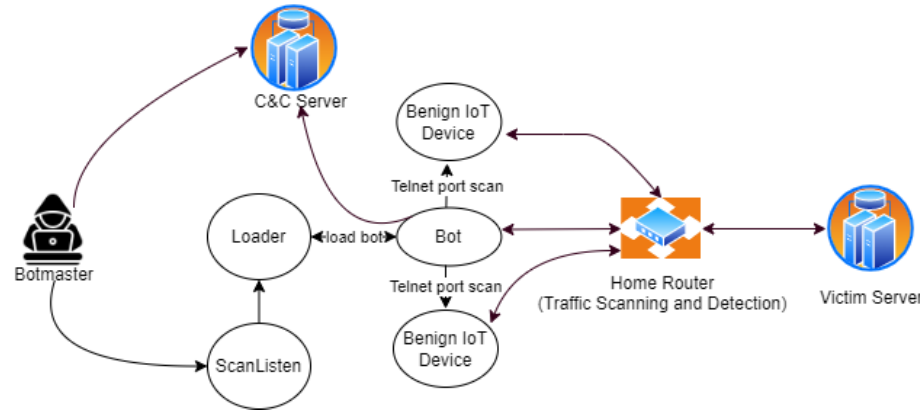
Figure 1. The working mechanism of the proposed scheme .